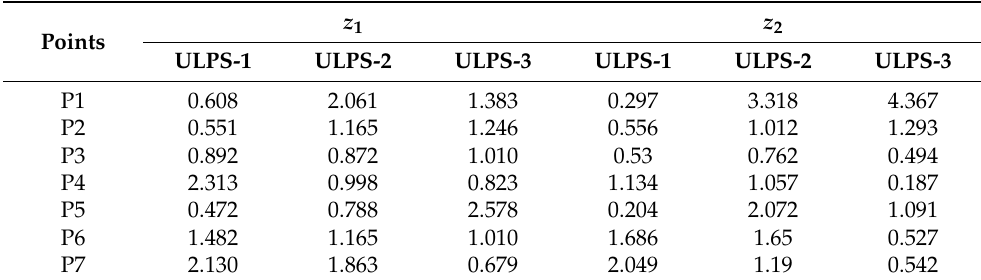
Table 9. Positioning error containing 90% of the estimated positions at z 1 = 1.35 m and z 2 = 1.93 m when the three ULPSs operated independently.